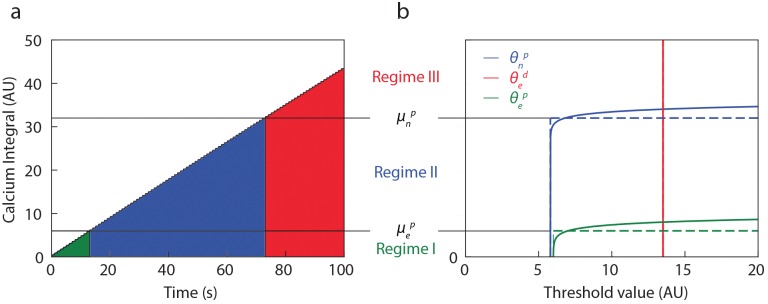
Activity-dependent thresholds.(a) Cumulative calcium concentration as a function of time for 100 pairings at 1 Hz (Δt = 0). (b) Thresholds for eCB-LTP (green), eCB-LTD (red) and NMDAR-LTP (blue) as a function of the cumulative calcium concentration (dotted lines: piecewise constant model, solid lines: exponential thresholds, ϵ = 1). Three typical regimes of plasticity emerge depending on which pathway is activated (see text).